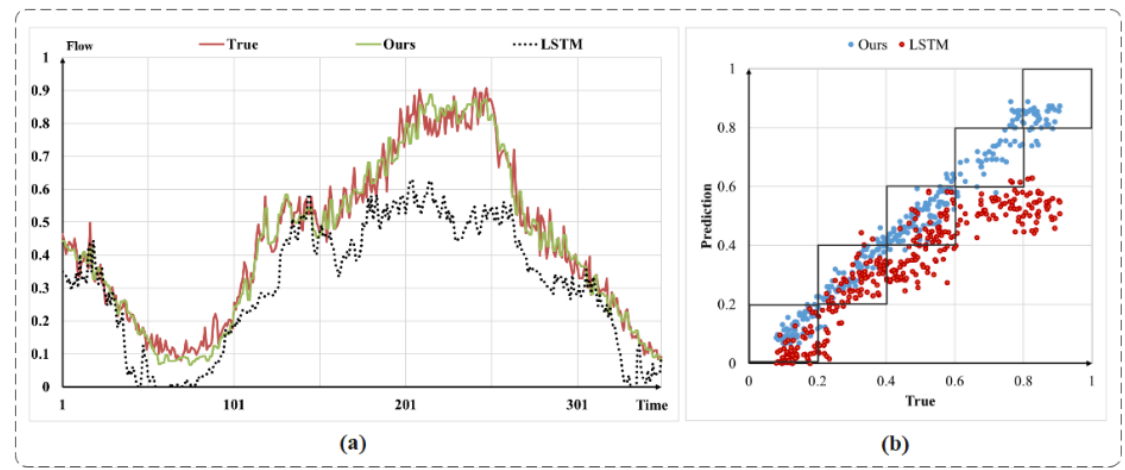
Figure 7. Comparison of DSGCN and LSTM prediction results. ( a ) is a time-series variation plot. ( b ) is a numerical scatter plot.